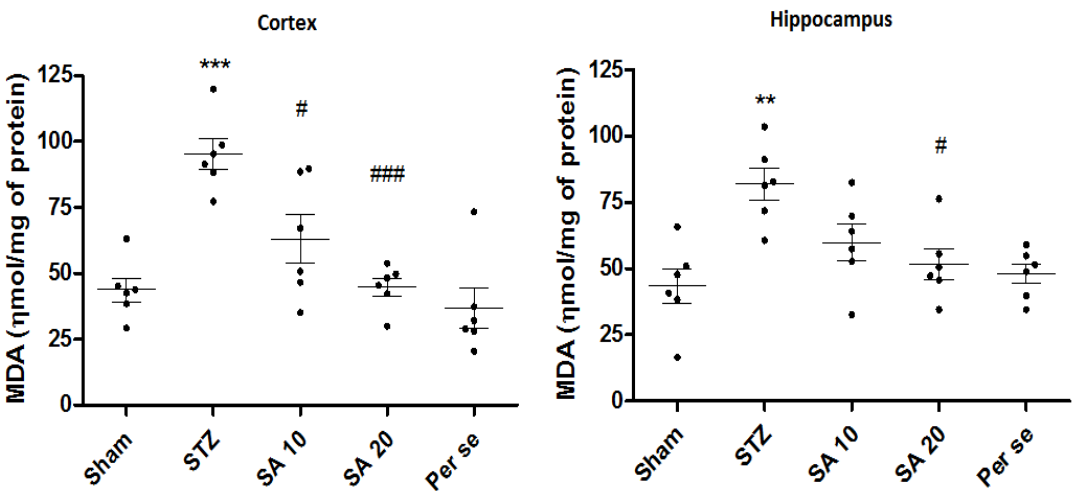
Figure 6. Effect of sinapic acid on MDA levels in the cortex and hippocampus. Data are presented as mean ± SEM, ( n = 6). * as compared to the sham group, # as compared to the STZ group. ** p < 0.01, *** p < 0.001, # p < 0.05, ### p < 0.001. STZ—Streptozotocin, SA—Sinapic acid.